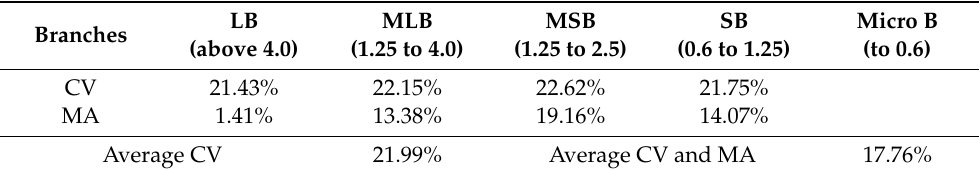
Table 7. Multi-criteria analysis “costs maximization” (5 groups).